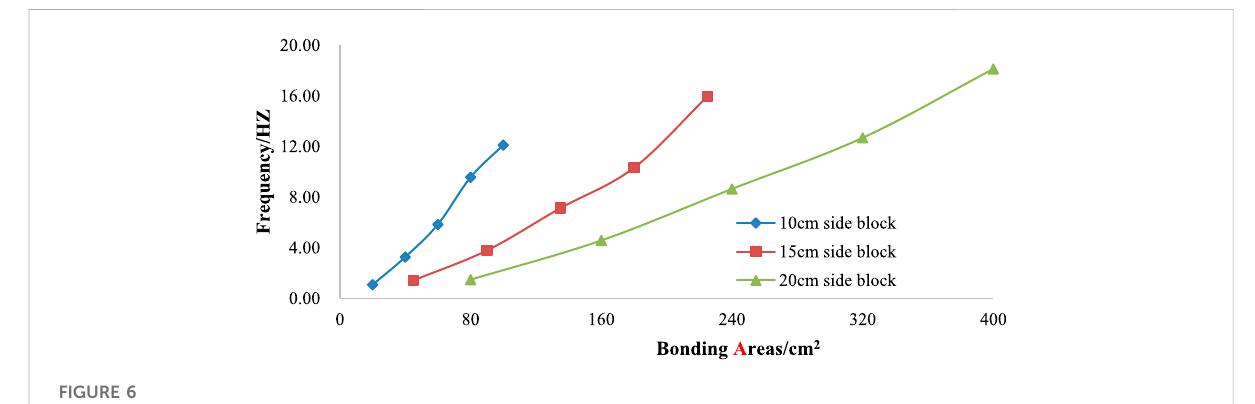
FIGURE 6 Natural vibration frequency of different size blocks with different bonding